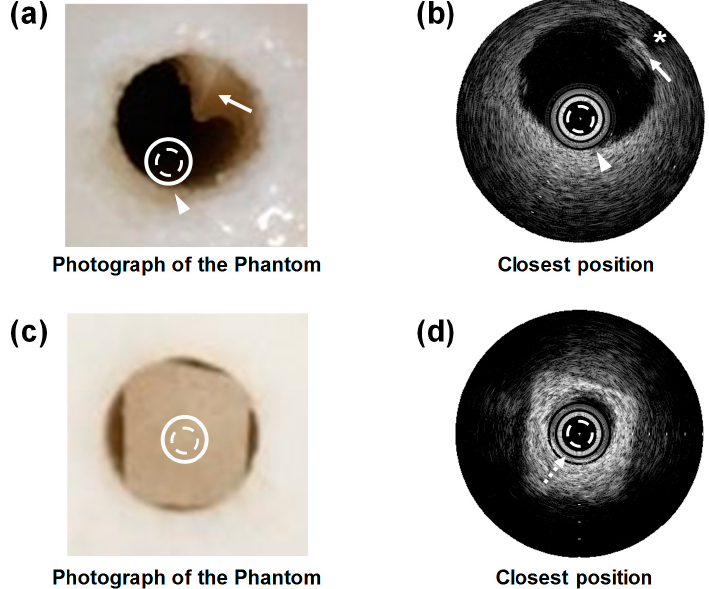
Figure 7. ( a , c ) Photographs of the custom blood-vessel-mimicking phantoms and ( b , d ) FL–IVUS images inside the hole of the each phantom. The white solid arrows in ( a , b ) indicate hyperechogenic regions (i.e., the calcification-mimicking parts), and the white arrow heads in ( a , b ) are the boundary between the water and the tissue-mimicking phantom. The space between the white bars on the IVUS images indicates 1 mm in the slant height. The holes in ( a , c ) are 5 mm in diameter.